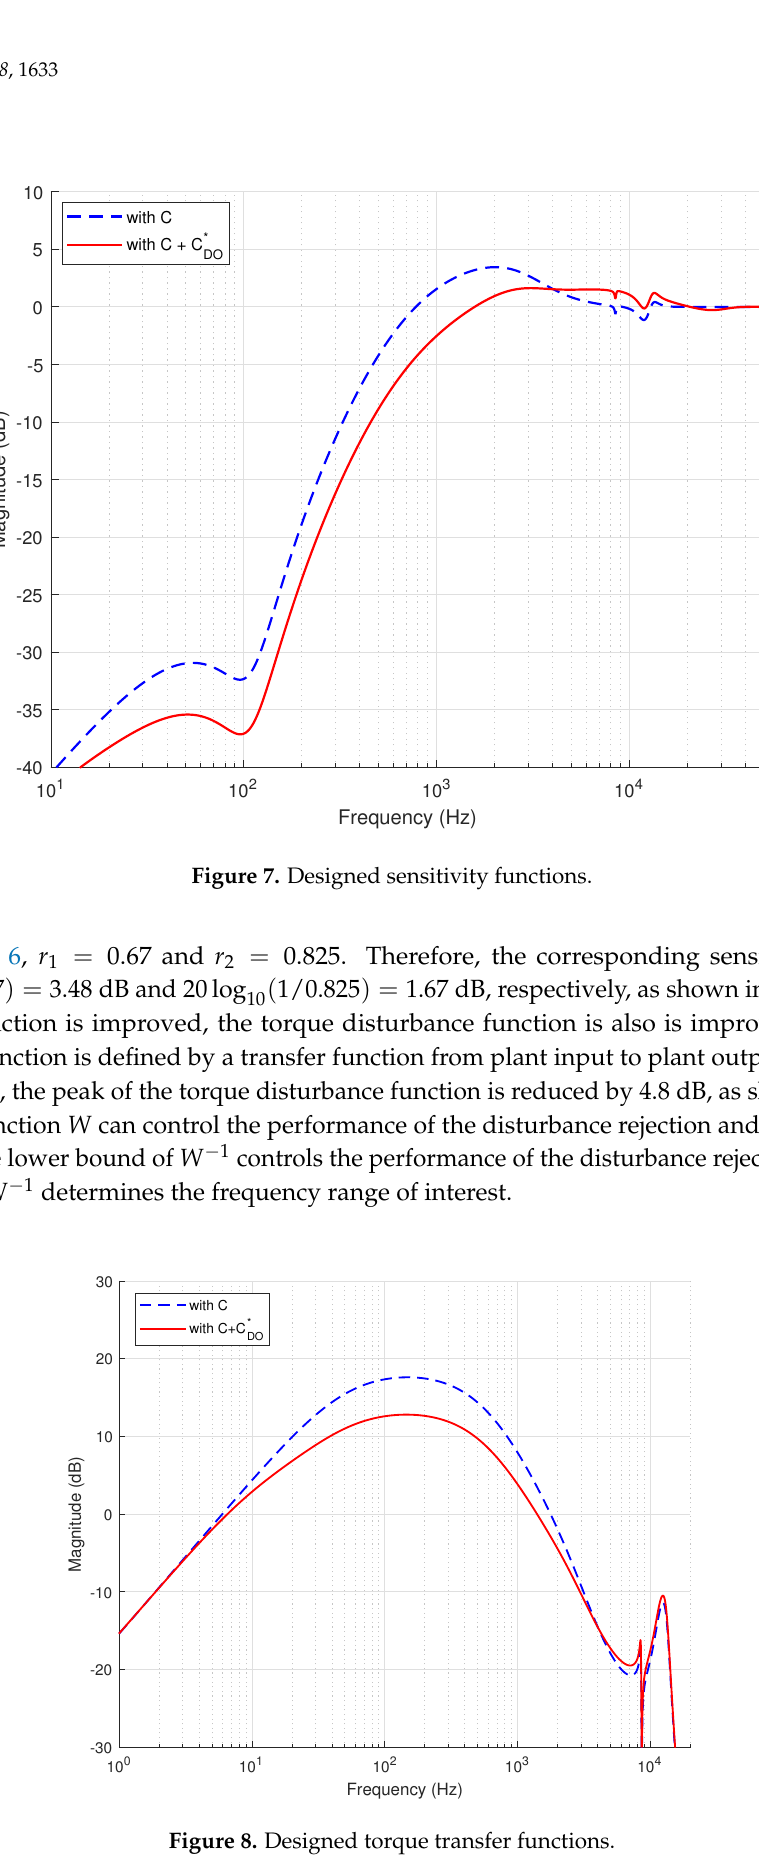
Figure 8. Designed torque transfer